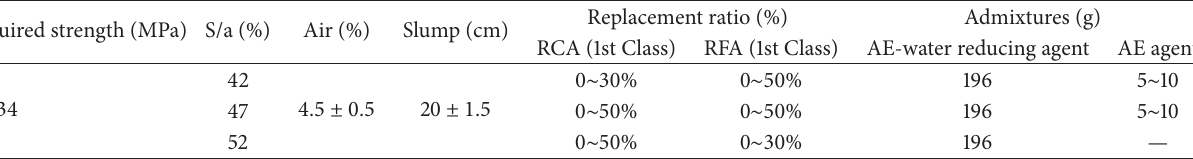
Table 3: Summary of results (approximate range of each parameter).